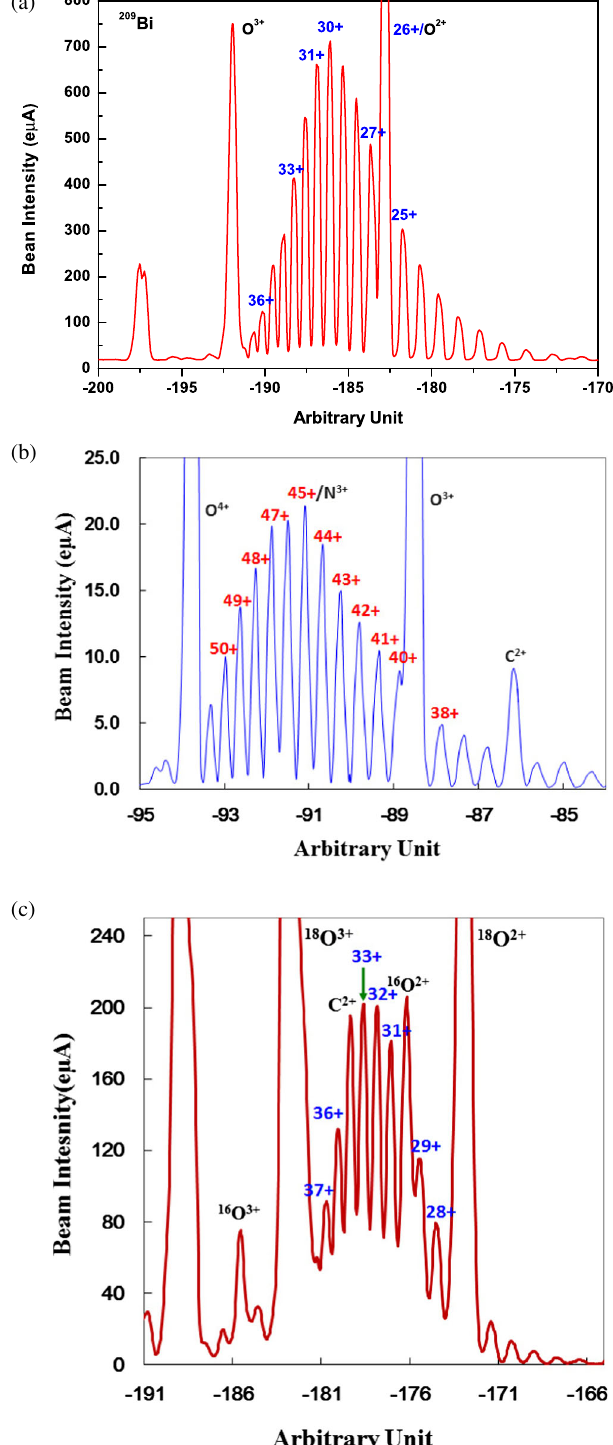
FIG. 15. CSD spectra with the source tuned for 209 Bi 31 þ , 209 Bi 50 þ and 238 U 33 þ . (a) Bismuth CSD spectrum with the source optimized for 209 Bi 31 þ at total microwave power 5.1 kW of 24 þ 18 GHz. (b) Bismuth CSD spectrum with the source optimized for 209 Bi 50 þ at total microwave power 4.3 kW of 24 þ 18 GHz. (c) Uranium CSD spectrum with the source optimized for 238 U 33 þ at total microwave power 3.7 kW of 24 þ 18